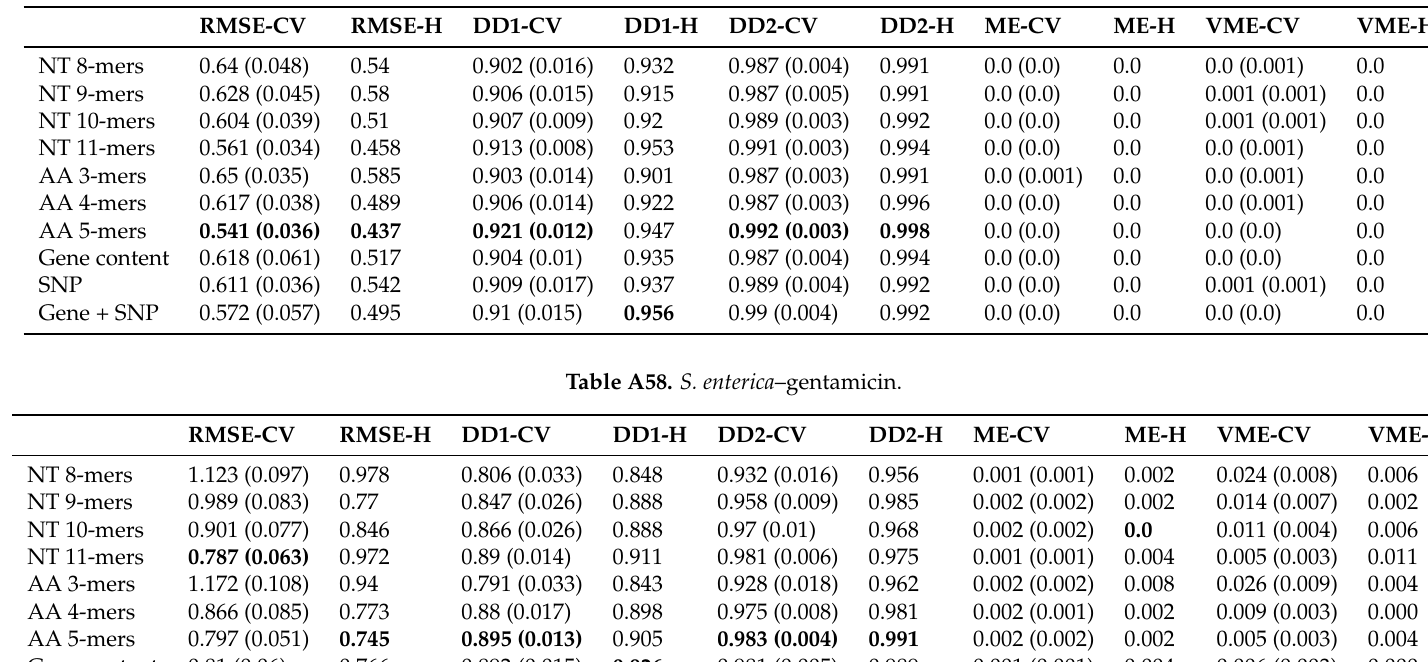
Table A57. S. enterica –ciprofloxacin.